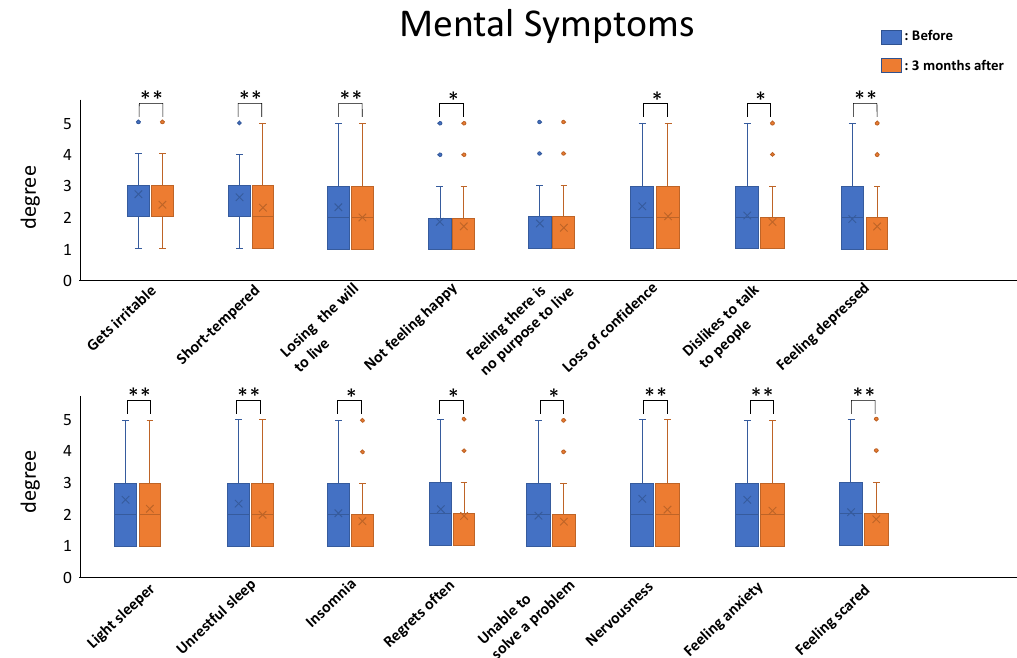
Figure 3. The mean values of degrees of mental symptoms. Blue bars indicate the mean scores before therapy, and orange bars indicate the mean scores after 3 months of nutritional therapy. Error bar indicates 2xSTDEV.S and Blue and Orange circles indicate outlier beyond 2xSTDEV.S. All symptoms tended to decrease, and 15/16 of the mean scores showed statistically significant differences from before to after nutritional therapy ( t -test: n = 253 *: p ≤ 0.05; **: p ≤